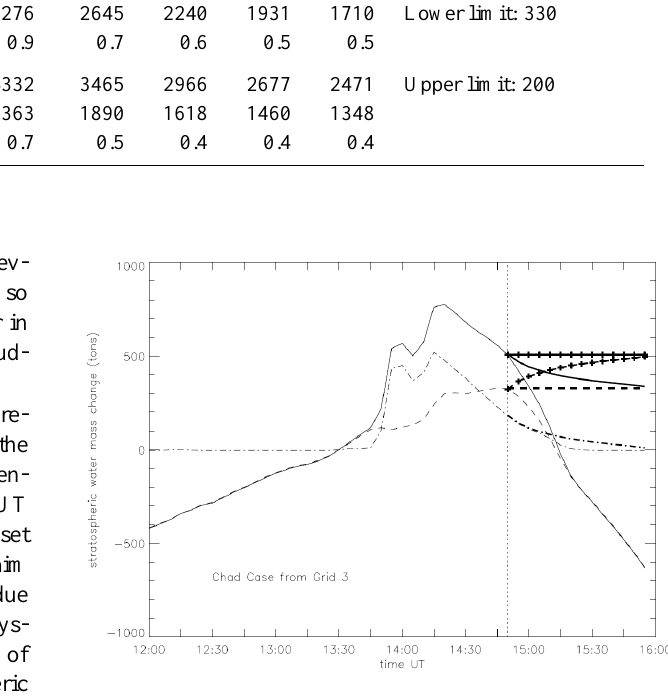
Fig. 15. Stratospheric water mass change associated to the Chad case overshoot computed from Grid 3 (thin lines) between the 380K and the 410K levels. Total water (solid line), water vapour (dashed line), and ice (dotted-dashed line) are shown. The reference value is set to zero when ice starts to appear in the stratosphere. The vertical dotted line at 14:50UT indicates that the hydrated signal in the stratosphere starts to exit from grid 3. From this time, the use of several hypotheses is shown in thick lines. The dashed-dotted thick line is ice mass change computed in Grid 2. The thick dashed line assumes a constant vapour amount from 14:50UT (no sublimation of ice that is finally completely removed by sedimentation). The thick solid line is the sum of the corresponding thick vapour and ice lines. The thick lines with “plus” marks assume that all the ice sublimates into vapour without any loss by